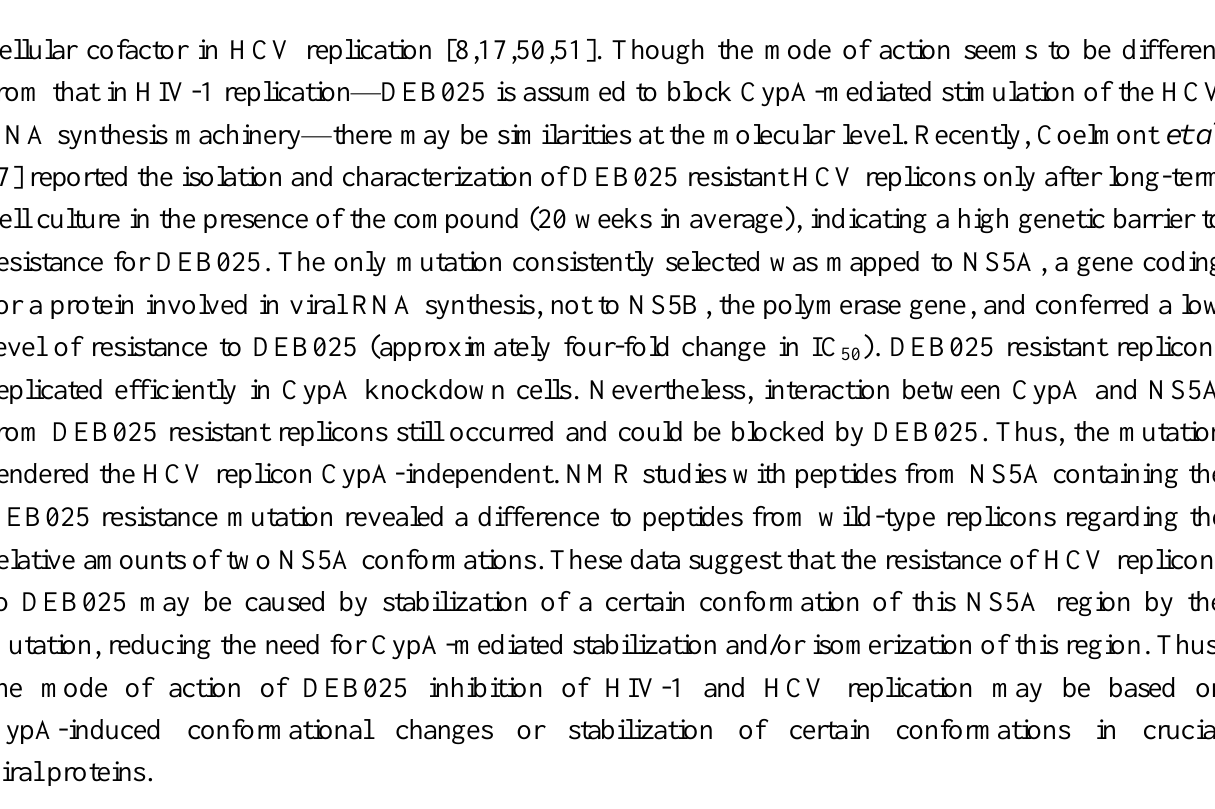
Table 2. Capsid polymorphisms in HIV-1 isolates from DEB025 clinical trial and correlation with sensitivity to